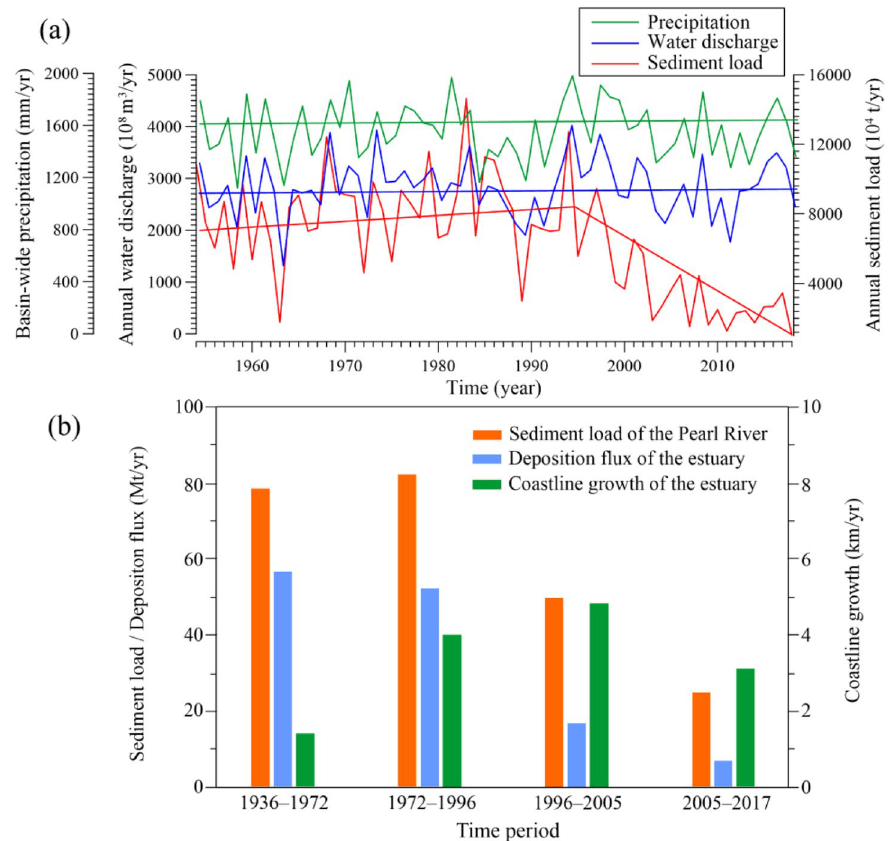
Figure 4. Annual precipitation, water discharge and sediment load of the Pearl River from 1954 to 2018 ( a ), and relationship between the sediment load from the Pearl River and the growth of the coastline and deposition flux of the estuary in different periods ( b ). Histograms and line charts created with Grapher, Version 2016, https:// www. golde nsoft ware. com/ produ cts/ graph